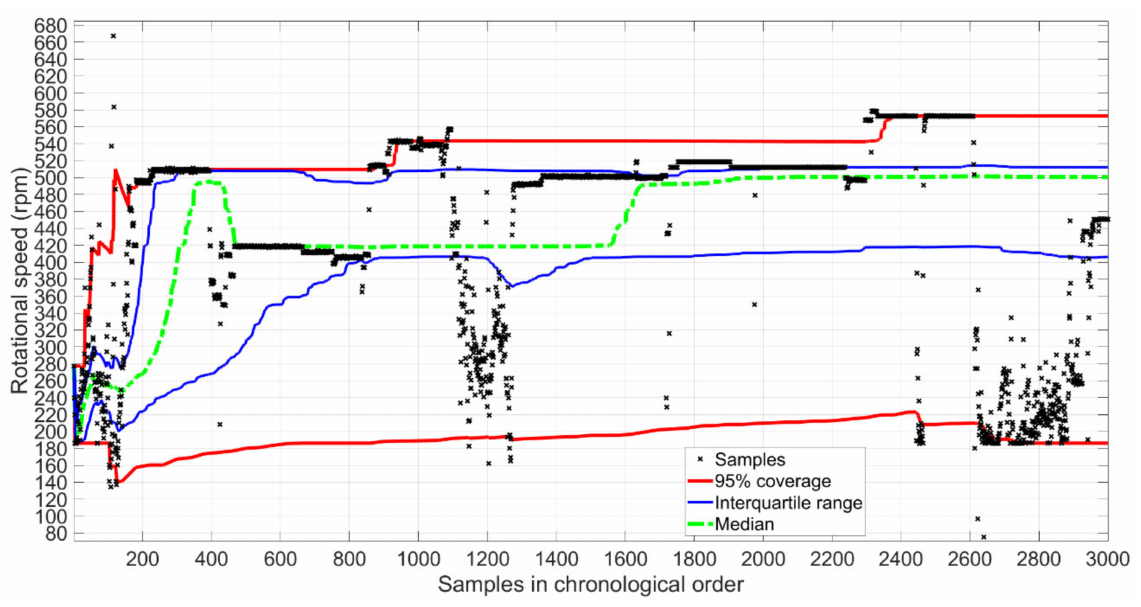
Figure 4. Shaft speed values of samples in chronological order and the progression of distribution based on median, interquartile range and 95% coverage.